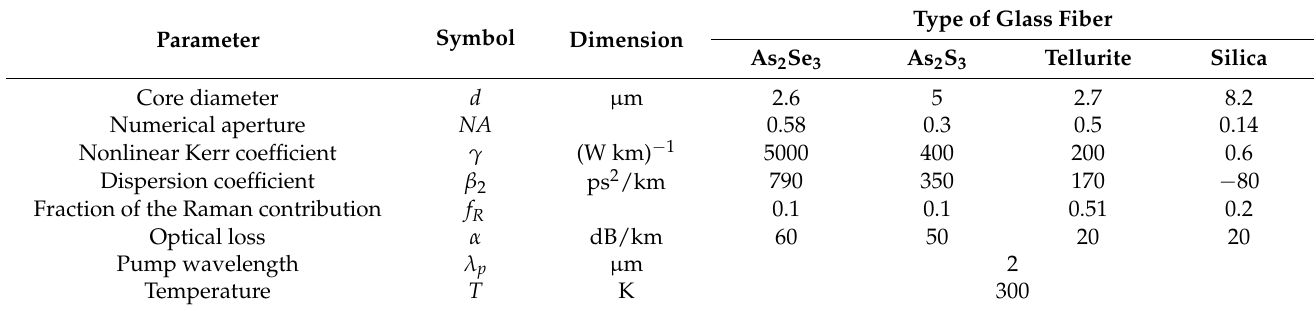
Table 1. Parameters used in simulations of quantum noise squeezing.